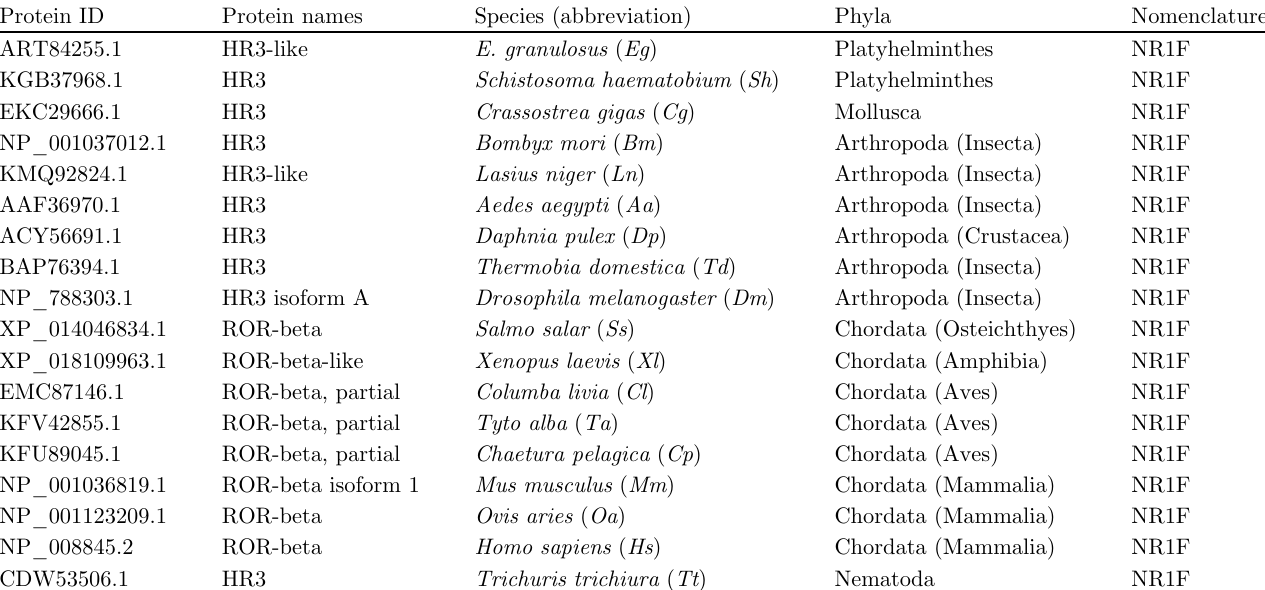
Table 1. Sequences used for alignment and phylogenetic analysis. Protein